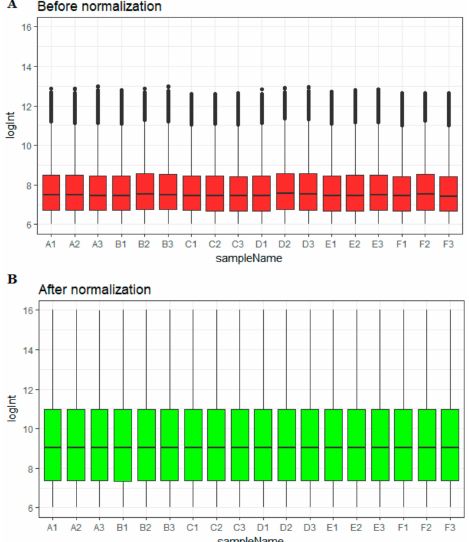
Figure 2. Box plots of the gene expression data before ( A ) and after ( B ) normalization. The horizontal axis represents the sample symbol, and the vertical axis represents the gene expression values. The black line in the box plot represents the median value of gene expression. (A1, A2, A3 = T47D (wild type genotype + estradiol); B1, B2, B3 = T47D (wild type genotype + none); C1, C2, C3 = T47D (wild type genotype + tamoxifen); D1, D2, D3 = T47D (overexpressing Split Ends (SPEN) + estradiol); E1, E2,